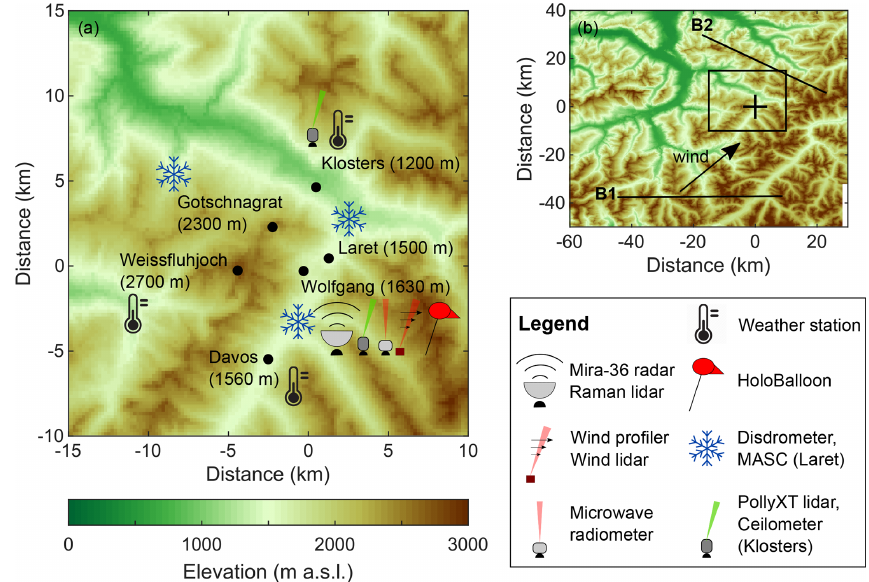
Figure 1. Overview of the measurement location and setup. The geographical location of Davos (black cross) and the surrounding topography are shown in (b) . The large-scale wind direction during the event is shown by the black arrow, and the relevant mountain barriers are indicated by B1 (upstream mountain barrier) and B2 (downstream mountain barrier). An enlarged section of the measurement sites (black rectangle in b ) and the instrument setup are shown in (a) . The elevation data were obtained from the digital height model DHM25 of the Federal Office of